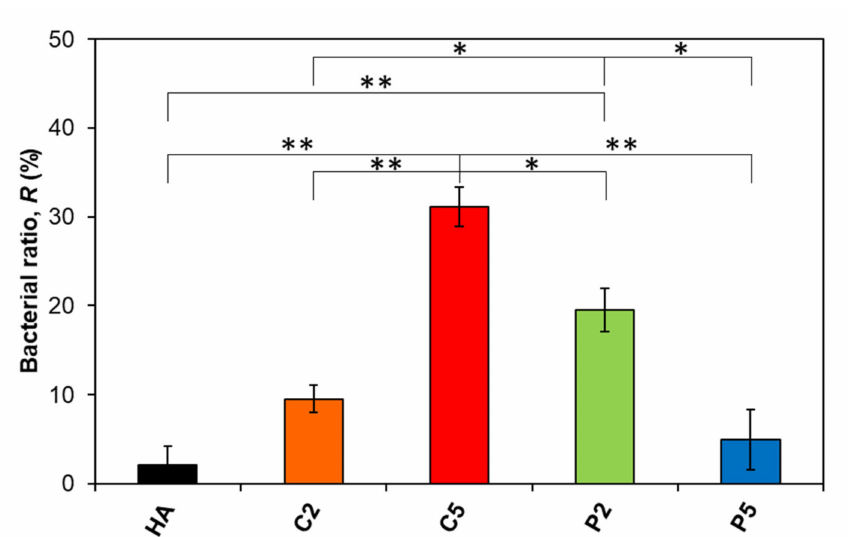
Figure 6. Change in the bactericidal ratio of the AgHA series. (** p < 0.01, * p < 0.05). The ratio was 2.1% for pure HA, which was the minimum value among the